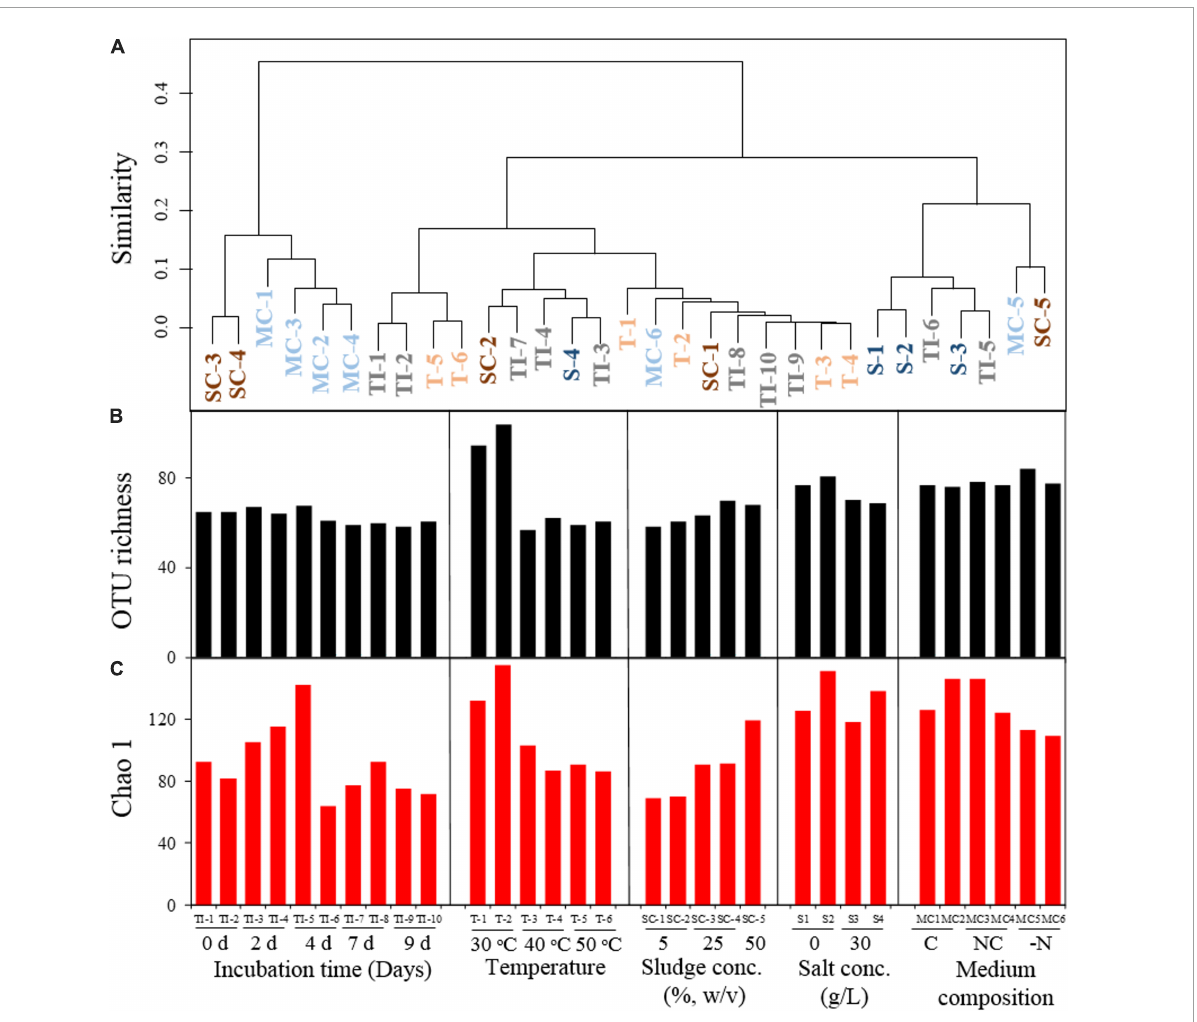
FIGURE3 Hierarchical cluster diagram based on Bray-Curtis dissimilarity (A) comparing the AK6 bacterial culture composition under different oily sludge biotreatment conditions and a bar plot comparing the changes in OUT richness (B) and Chao1 diversity indices (C) among the different treatments. MC: medium composition [C: complete medium, NC: without complement (vitamins, trace elements, MgCl 2 , CaCl 2 and FeCl 2 ), -N: without nitrogen